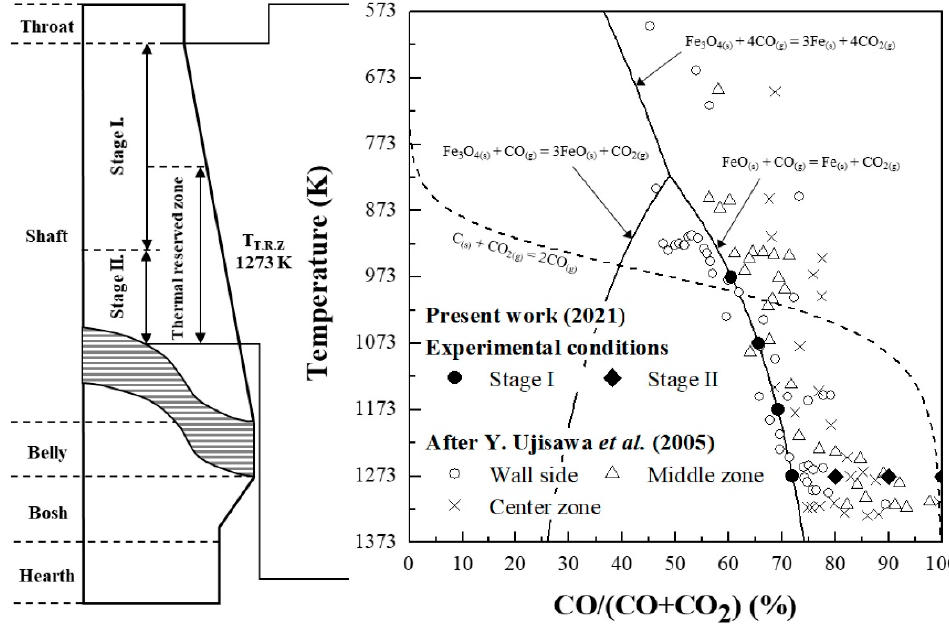
Figure 1. Schematic representation of experimental conditions of Stage I and Stage II with reduction conditions of a conventional blast furnace.